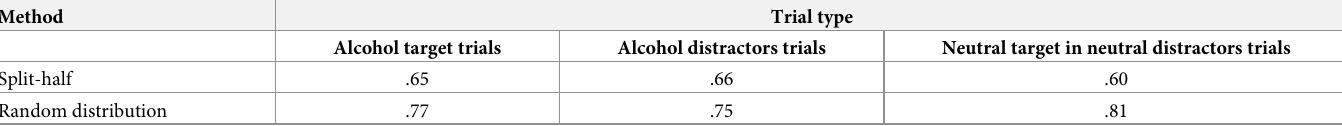
Table 4. Internal consistency reported for the split-half and random distribution method per trial type for the Odd-One-Out